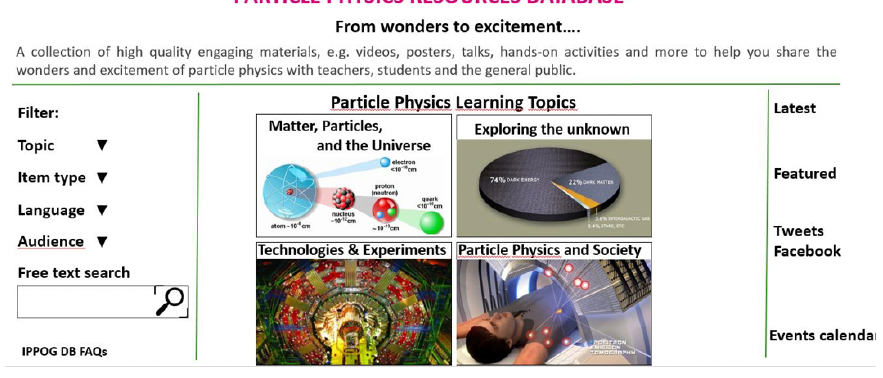
Figure 3. Proposal on how to search in the IPPOG Resource Database